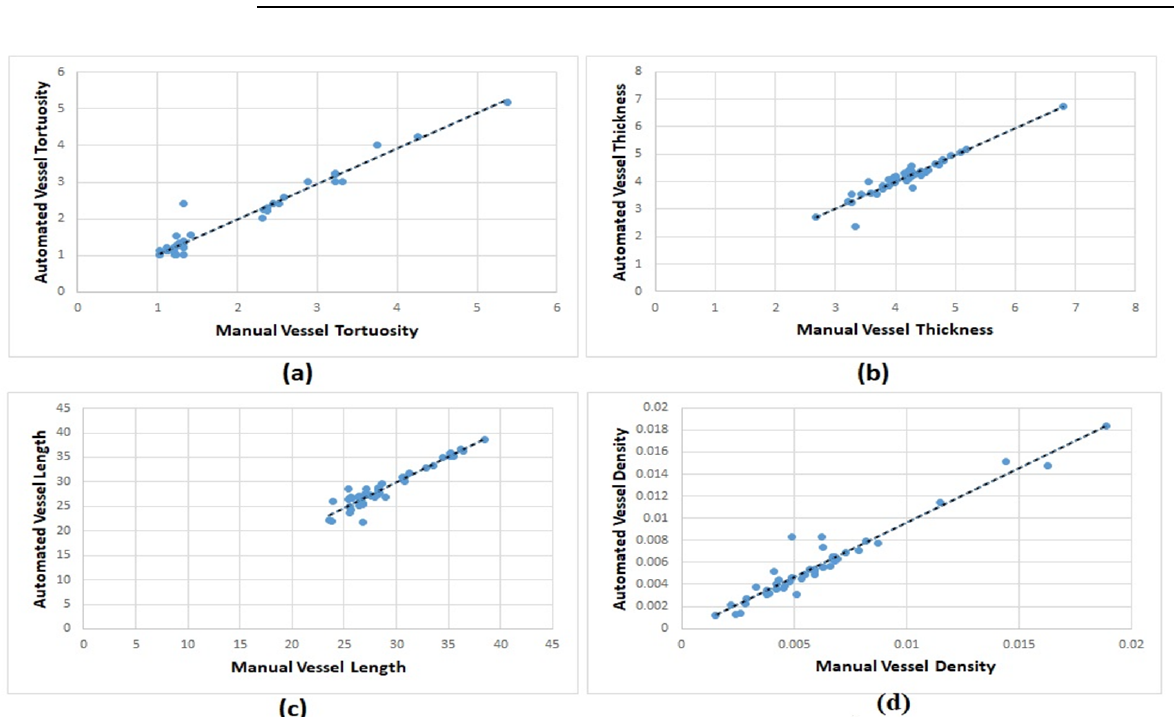
Figure 16. Correlation plots between the manual and automated clinical estimations for the HRF dataset using the proposed trainable filters algorithm: ( a ) tortuosity; ( b ) thickness; ( c ) length; and ( d ) density.